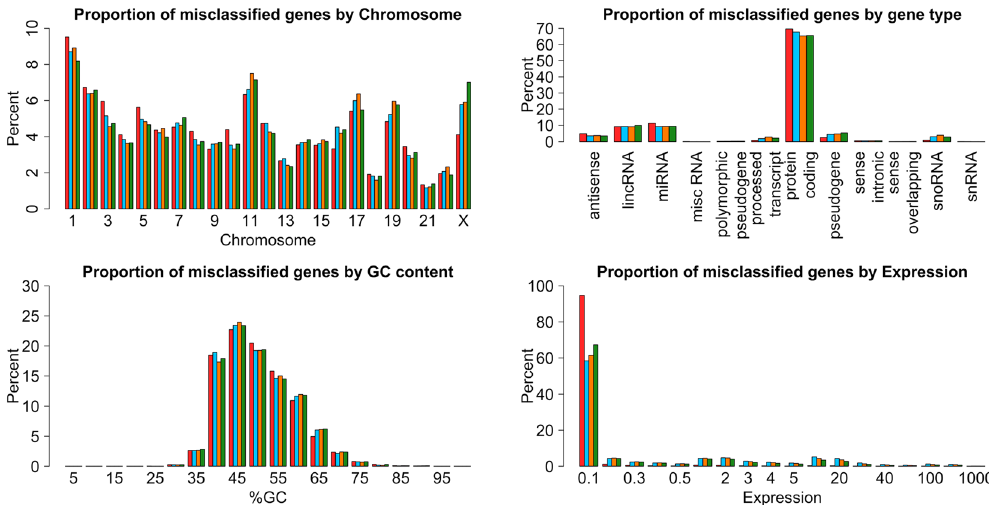
Figure 2. Comparison of our method to peak callers with respect to potential sources of bias. Potentially influencing factors for our predictions (red bars) where compared against F-Seq (blue bars), MACS (orange bars) and Hotspot (green bars). Neither, the chromosomal location nor gene type nor the GC content of misclassified genes distinguishes predictions from observations. However, by predicting accessibility based on gene expression (bottom right histogram), we significantly reduce the number of misclassified genes in regions expressed above 0.1 FPKM (6% compared to 41.6%, 38.6% and 37.2%). Due to the deterministic prediction, genes with no expression are overrepresented in the range of 0 to 0.1 FPKM (first bar, 38% out of 94%).